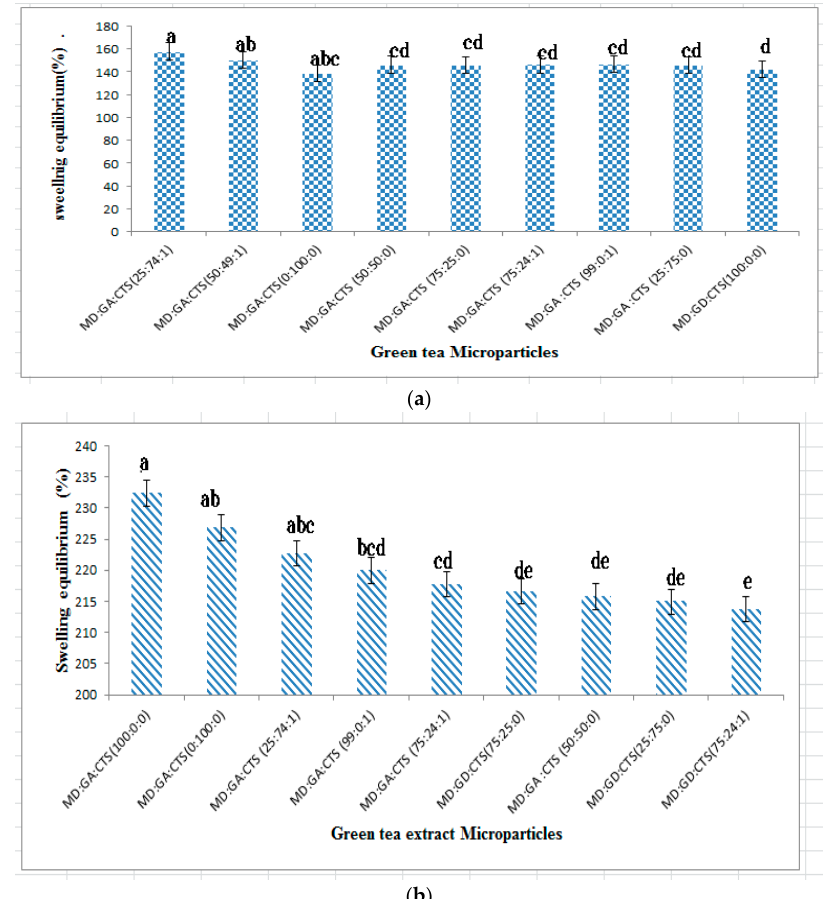
Figure 4. Swelling potentials of microparticles in ( a )simulated gastric fluid (pH 2.3) and ( b ) simulated intestinal fluid (pH 7.4) at 37 °C for 120 min. Values with different letters are significantly ( p ≥ 0.05) different. Values are presented as mean ± SD. (MD—maltodextrin, GA—gum arabic, CTS—chitosan). 2.4. Release of Phenolic Compounds (TPC), DPPH Scavenging Activity and Total Catechin (TC) from Simulated Gastrointestinal Fluids (pH 2.3)